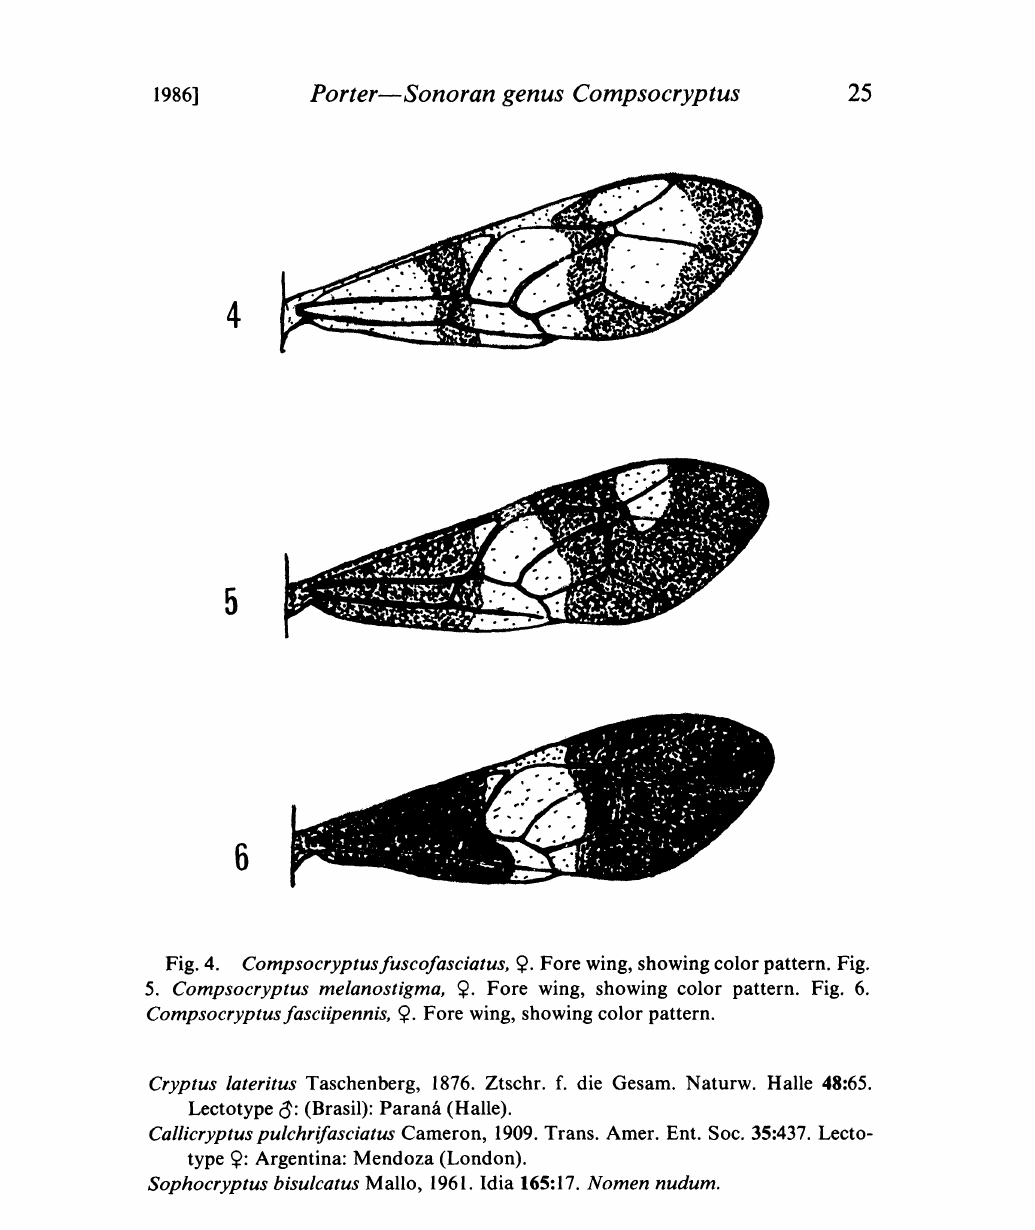
. . Fore wing, showing color pattern. Fig. Fig. 4. Compsocryptusfuscofasciatus, 5. Compsocryptus melanostigma, Q. Fore wing, showing color pattern. Fig. 6. Fore wing, showing color Compsocryptusfasciipennis,